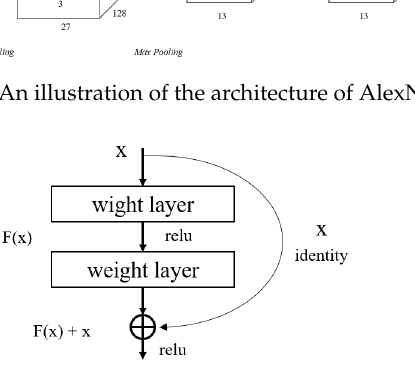
Figure 2. Residual learning: a building block in